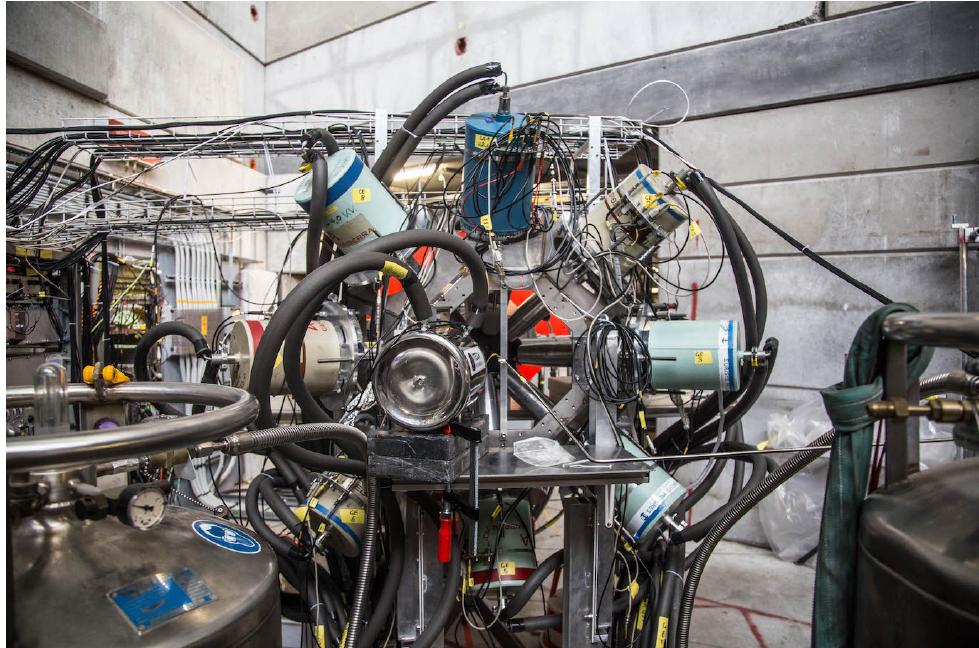
Figure 1. A photograph of the experimental setup showing the assembly of the